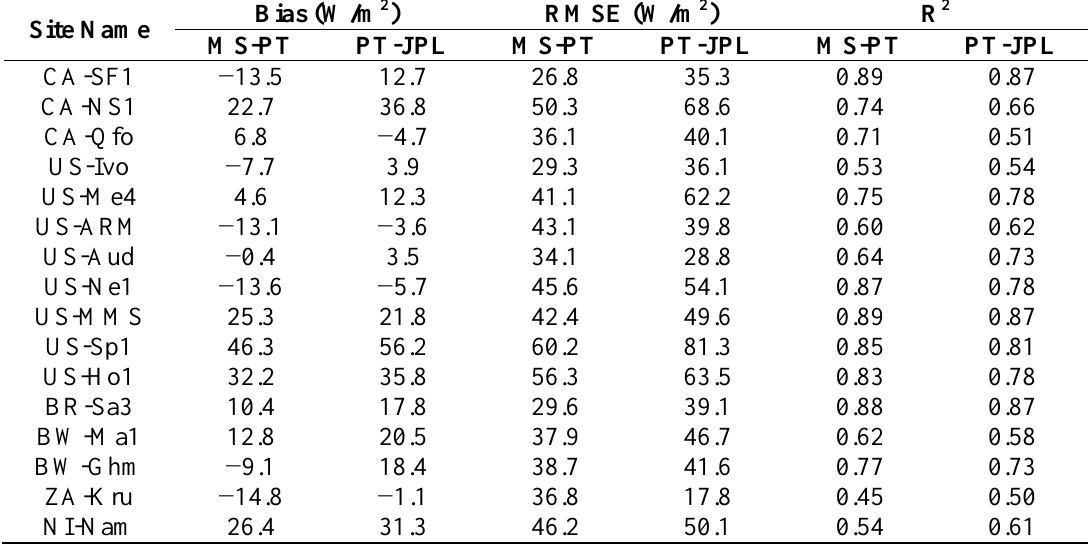
Table 2. Statistics of estimated daily LE against the eddy-flux tower observations. The bias and Root Mean Square Error (RMSE) are in units of W/m 2 . All r values are significant with 99%